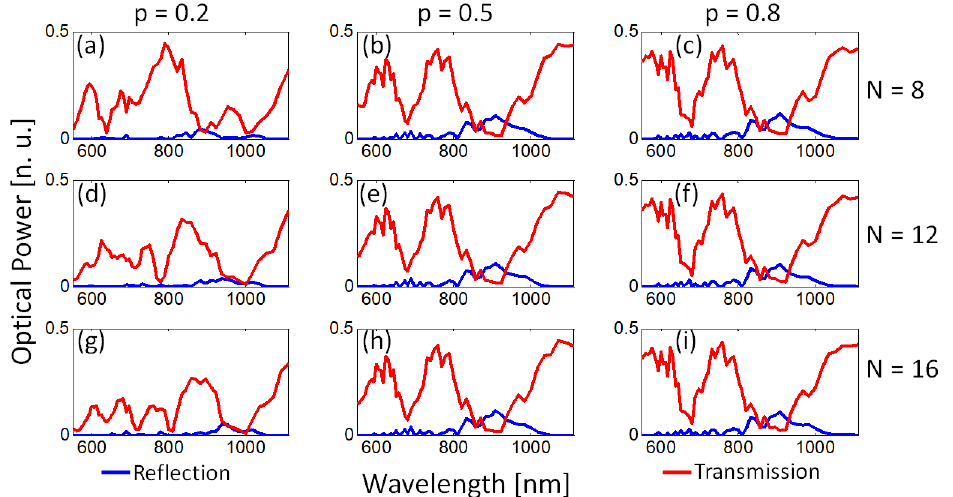
Figure 6. Dependence of the broad deeps as a function of the number of layers ( N ) and filling fraction ( p ). ( a – c ) N = 8, ( d – f ) N = 12, and ( g – i ) N = 16 for p = [ 0.2,0.5,0.8 ] , respectively. For p = 0.2, the number of deeps and their spectral position depends on the number of layers. For p = 0.5,0.8, the broad deeps remain almost the